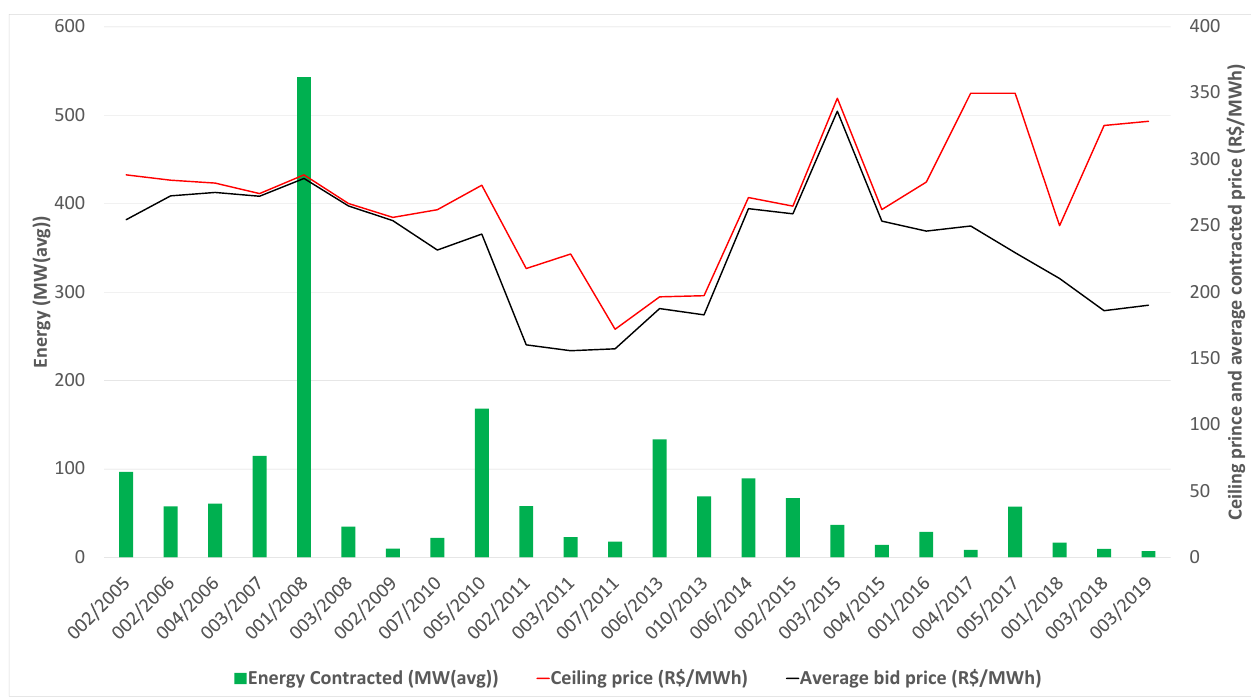
Figure 2. Auction prices and procured energy in MW (avg) for bioelectricity from 2008 to 2019 Based on [62,74].